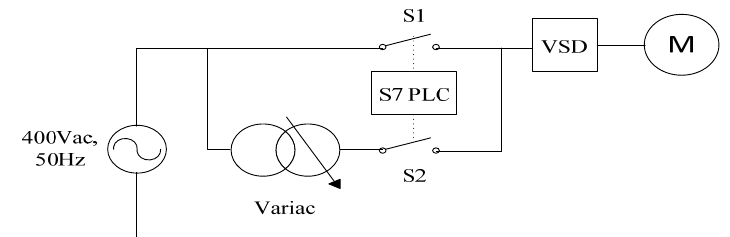
Figure 11. Voltage dip generator.